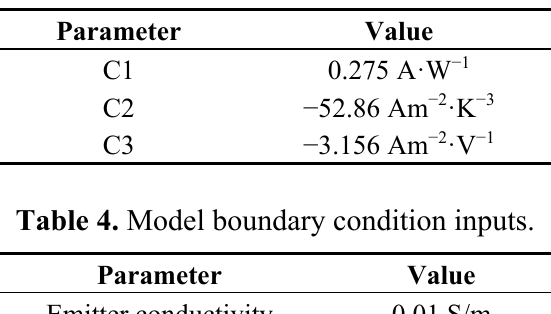
Table 3. PV Cell coefficients.